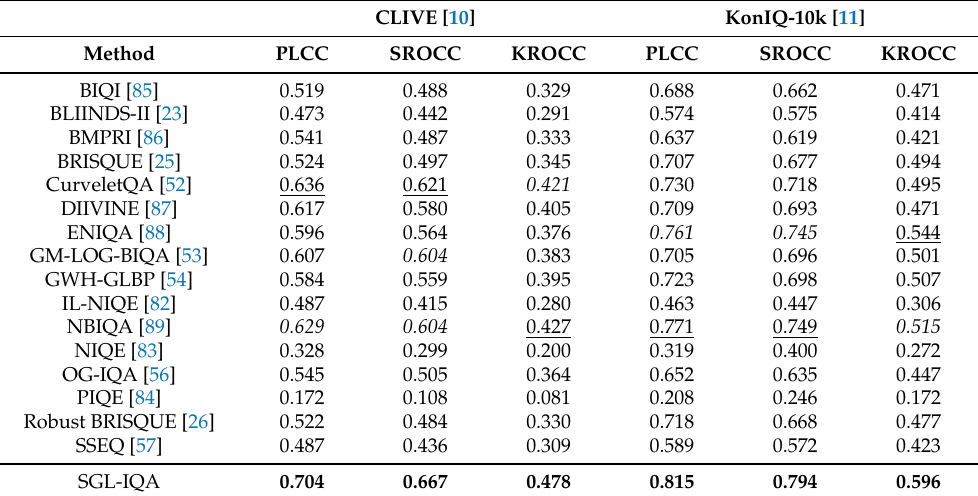
Table 3. Comparison to other state-of-the-art algorithms using CLIVE [10] and KonIQ-10k [11] databases. Median PLCC, SROCC, and KROCC values were measured over 100 random train-test splits. The best results are given in bold, the second-best results are underlined, and the third-best results are given in italics.